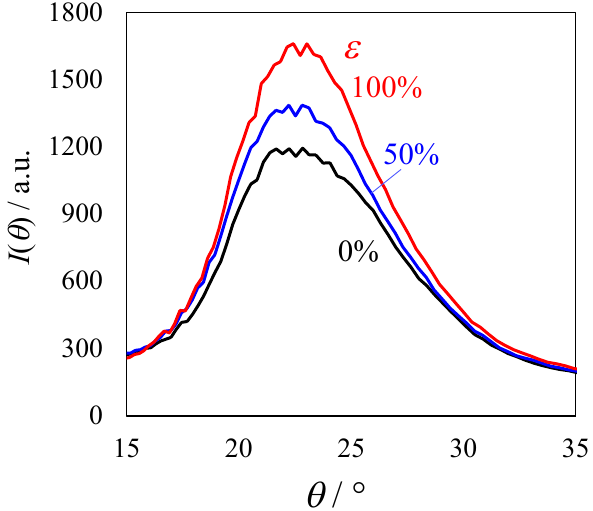
Figure 10. One-dimensional WAXD profiles of the heat-elongated TPU film ( λ = 300%) during uniaxial stretching at 23 °C at various strains ε.